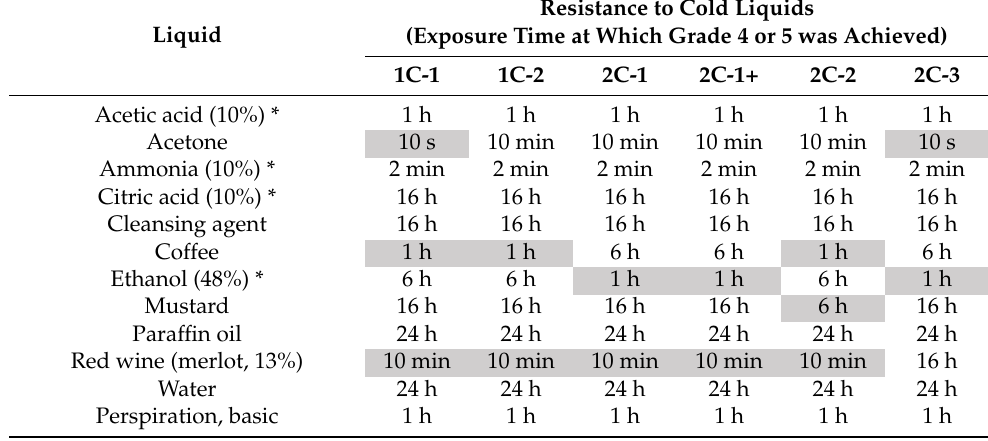
Table 7. Surface resistance to cold